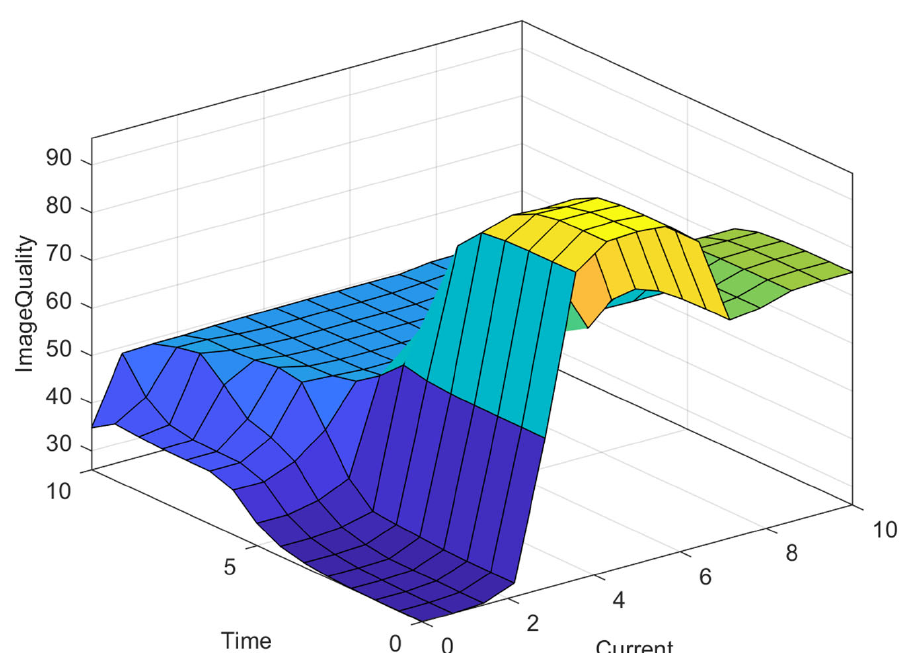
Figure 9. View of the model surface for the time and current.